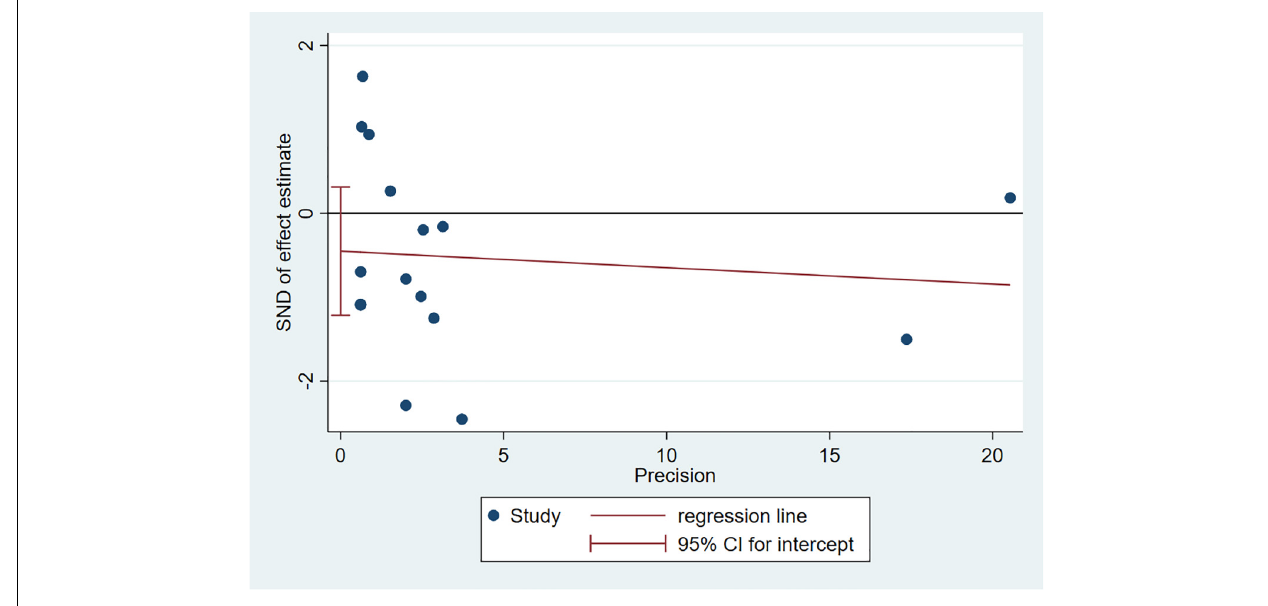
FIGURE 11 | Egger’s test.